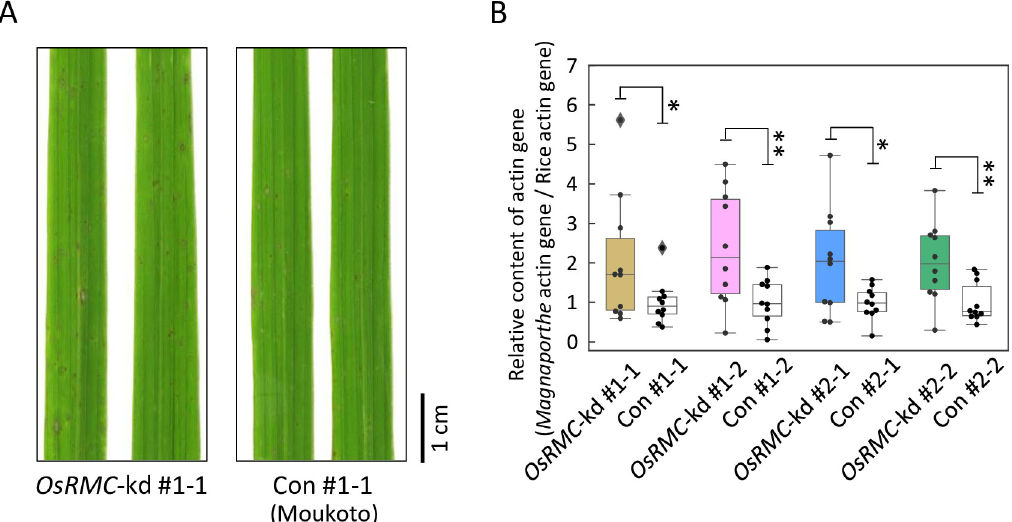
Fig 4. OsRMC -knockdown rice plants show reduced resistance to M . oryzae . (A) Rice leaves of OsRMC -knockdown ( OsRMC- kd) and wild-type (Moukoto) control (Con) lines 4 days after inoculation of M . oryzae (Ken53-33, 3.0 X 10 5 conidia). The M . oryzae infection test was conducted using T 1 OsRMC- kd and wild-type control progenies ( n = 10) derived from selfing of T 0 heterozygous OsRMC -kd lines. (B) M . oryzae infection is enhanced in OsRMC- kd rice. The amount of M . oryzae fungal mass in rice leaf was monitored by quantifying the ratio of M . oryzae genomic DNA to rice genomic DNA, determined by qPCR of the respective actin genes. The average ΔΔ Ct value in wild-type control lines was defined as the unit for the ratio. Data are means ± SD of 10 independent determinations. Single and double asterisks indicate a significant difference at P < 0.05 and P < 0.01, respectively, according to Student’s t